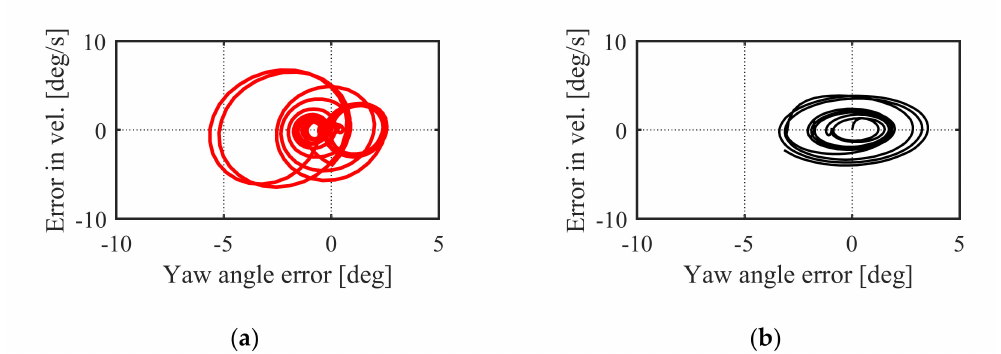
Figure 10. The phase-portrait: ( a ) Proposed controller; ( b ) PID.